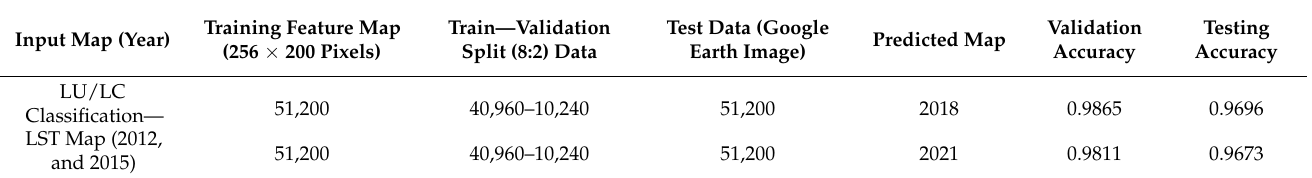
Table 8. Validation and testing process of the proposed Vision Transformer–based Bi-LSTM Prediction Model.